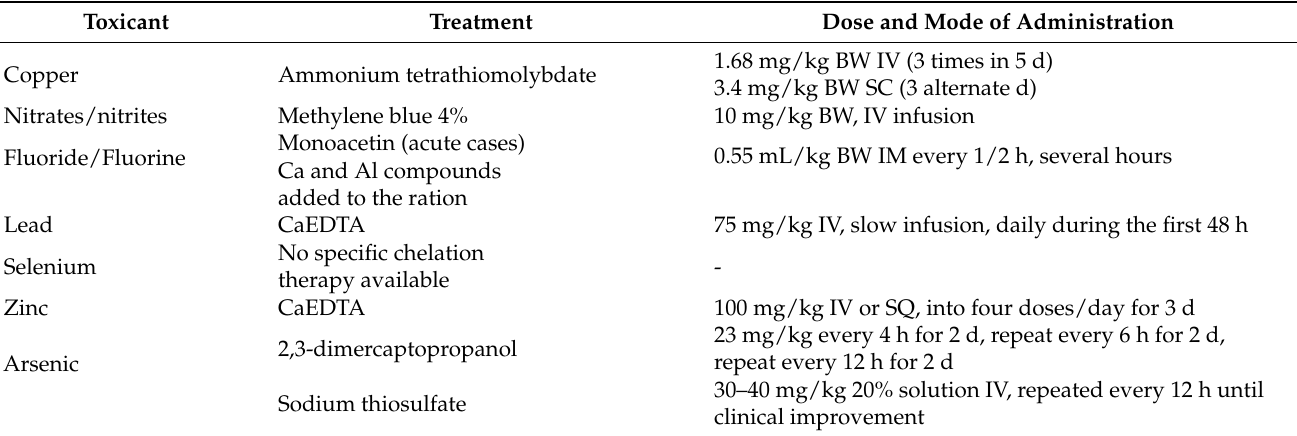
Table 1. Treatments protocols for different